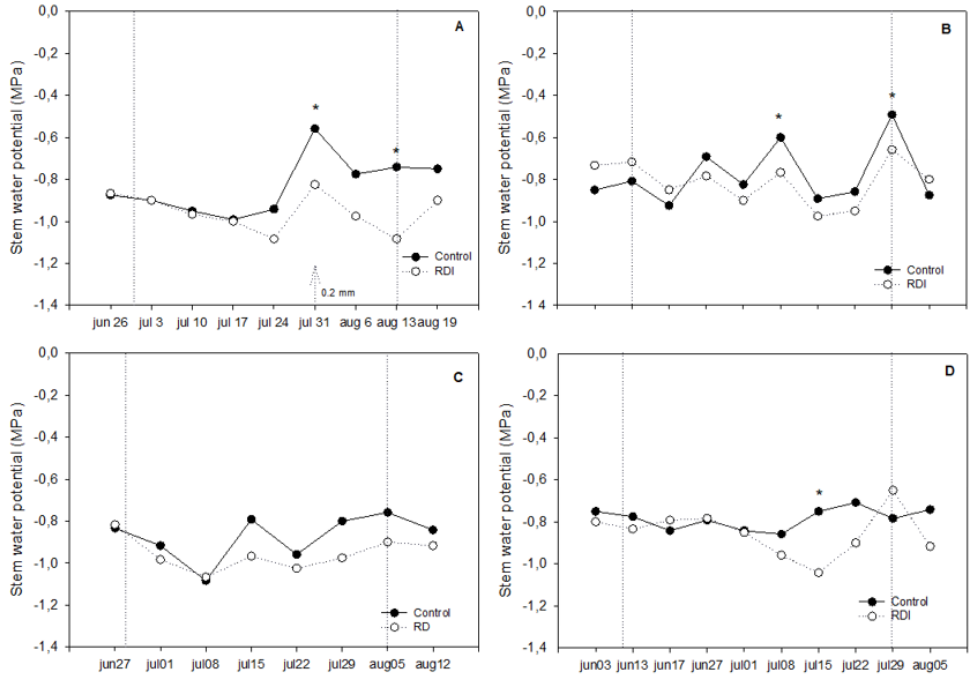
Figure 4. Stem water potential in control and regulated deficit irrigated (RDI) vines cultivated under net (left, A and C ) and under a plastic greenhouse (right, B and D ) in 2015 (top) and 2016 (bottom). Vertical lines mark deficit irrigation periods. Arrows represent the rain events during the deficit irrigation period. When present, * indicate significant differences between irrigation treatments ( p < 0.05).